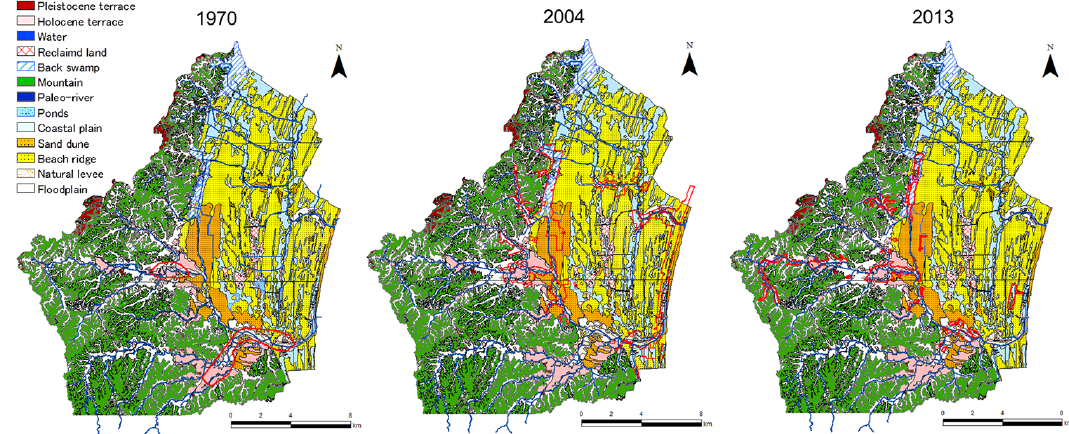
Figure 3. Geomorphological classification map in 1970, 2004, and 2013 based on land condition map (1 / 25000) of Geospatial Information Authority of Japan. Red line indicates flood inundation area.